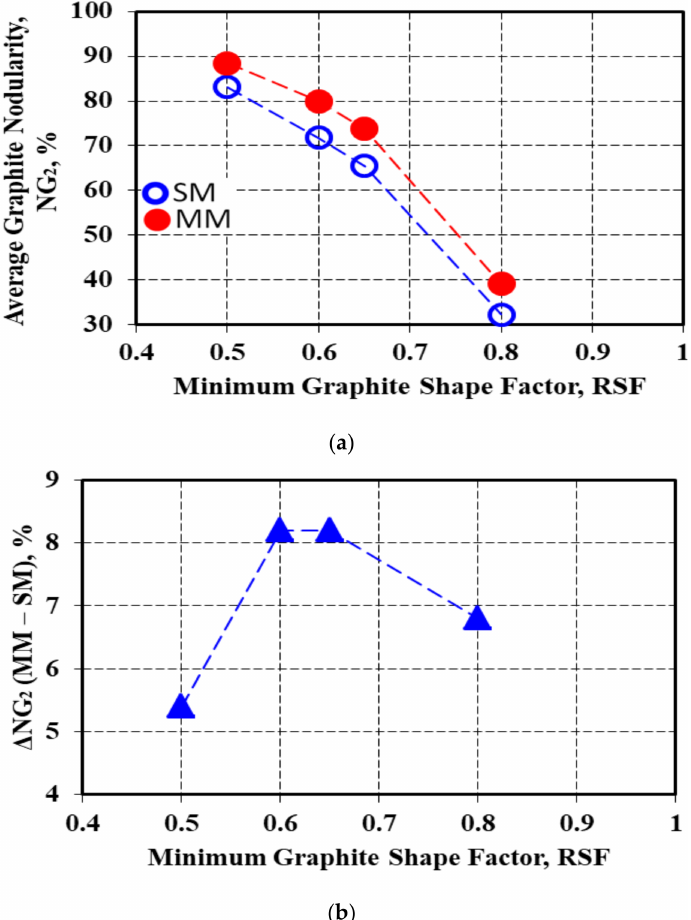
Figure 15. The average graphite nodularity NG 2 as a function of the imposed minimum graphite shape factor for the sand mold and metal mold solidification ( a ) and the difference between the metal mold and sand mold values ( b